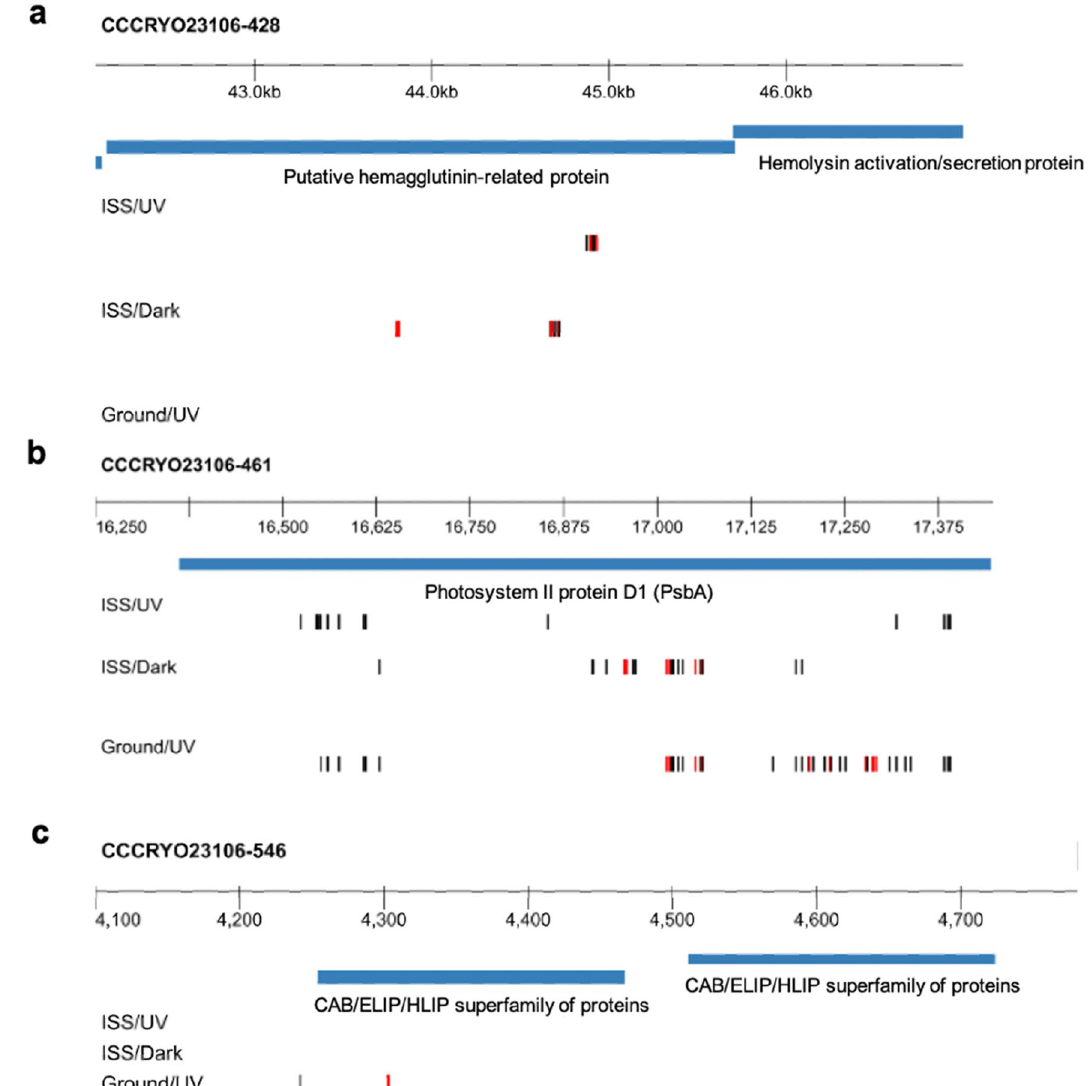
Figure 4. Plot of variants on BG11 medium detected in biofilm-associated hemagglutinin gene and photosynthesis-associated genes. ( a ) Biofilm-associated hemagglutinin genes. ( b ) Photosystem II D1 ( psbA ) gene. ( c ) High-light inducible protein genes. Each track represents a medium/exposure condition, and the blue markers represent variant positions with respect to the consensus reference genome for Nostoc sp. CCCryo 231- 06. Black vertical lines represent synonymous variants (not impacting amino acid translation), red vertical lines represent non-synonymous variants (impacting amino acid translation). ISS international space station, UV ultraviolet light, ISS/UV ISS with UV exposure, ISS/Dark ISS without UV exposure, Ground/UV earth with UV exposure.